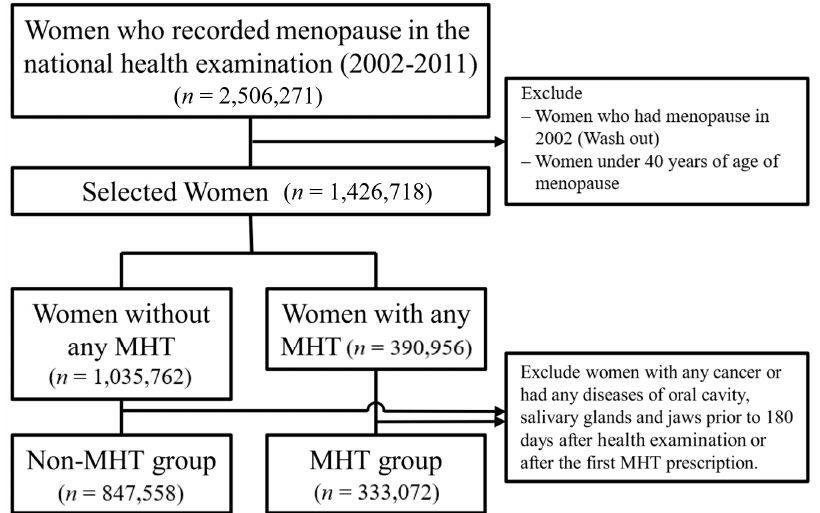
Figure 1. Flowchart to select case-control according to MHT using the Korea National Health Insurance Data, 2002–2019. MHT, menopausal hormone therapy.